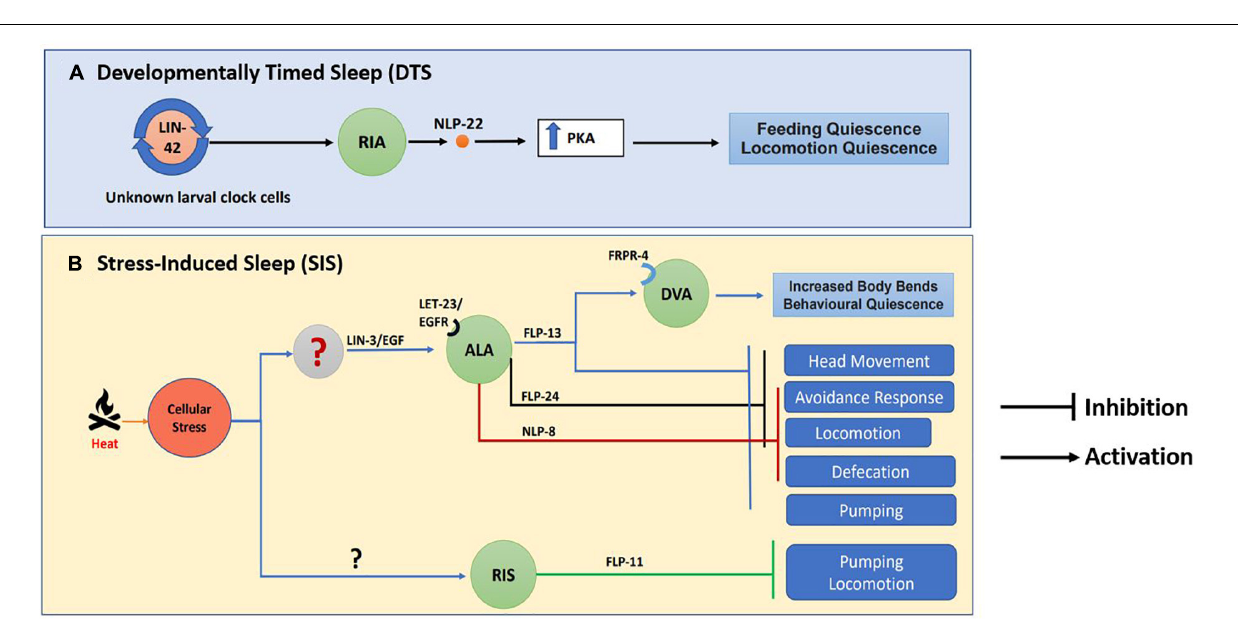
FIGURE 7 | Neuropeptide circuitry regulating sleep. The image indicates (A) Developmentally Timed Sleep (DTS) and (B) Stress Induced Sleep (SIS) along with the neuropeptides involved in each process. This image has been adapted from work by Nelson et al. (2013, 2014) and Nath et al.